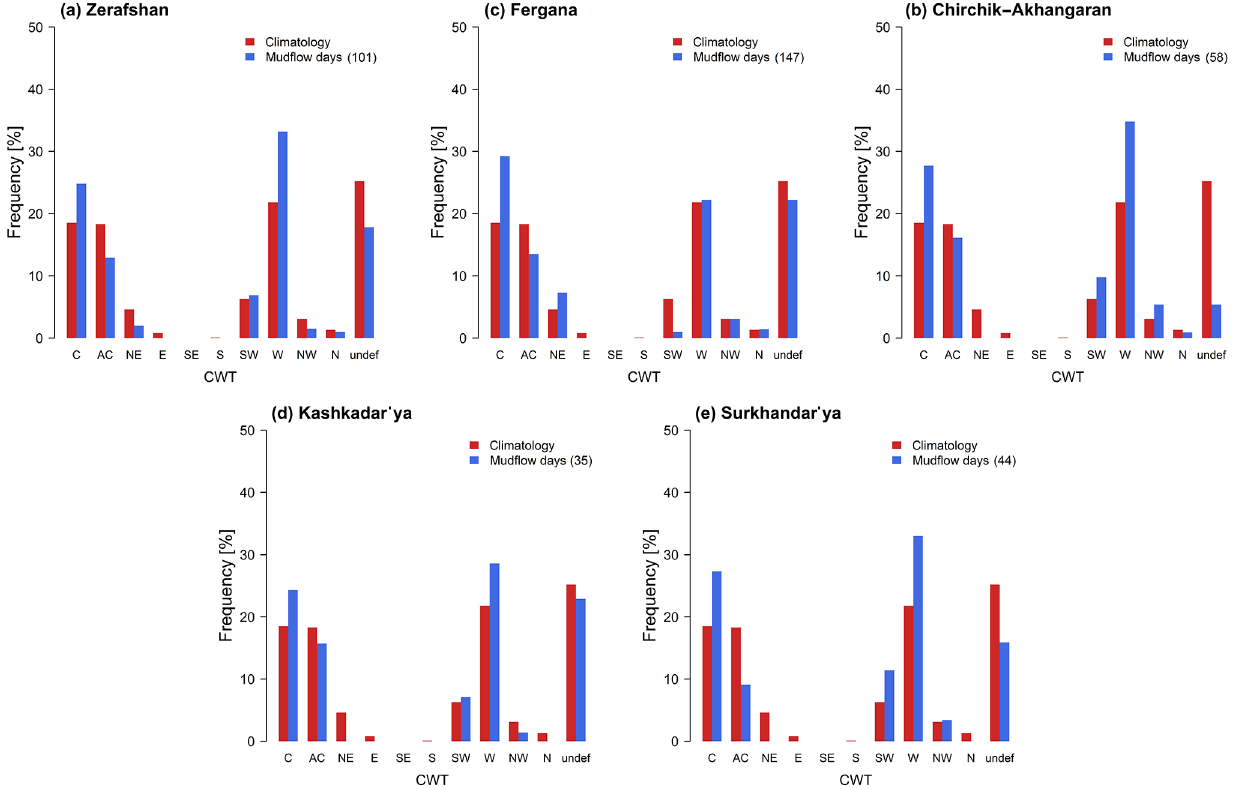
Figure 12. Frequency of CWT (700GPH) climatology for the period March–August, 1984–2013 (red bars), and mudflow days (blue bars) that occurred in the Zerafshan basin (a) , Fergana Valley (b) and the Chirchik–Akhangaran (c) , Kashkadar’ya (d) and Surkhandar’ya (e) basins in Uzbekistan. The central grid point is 40.0 ◦ N–67.5 ◦